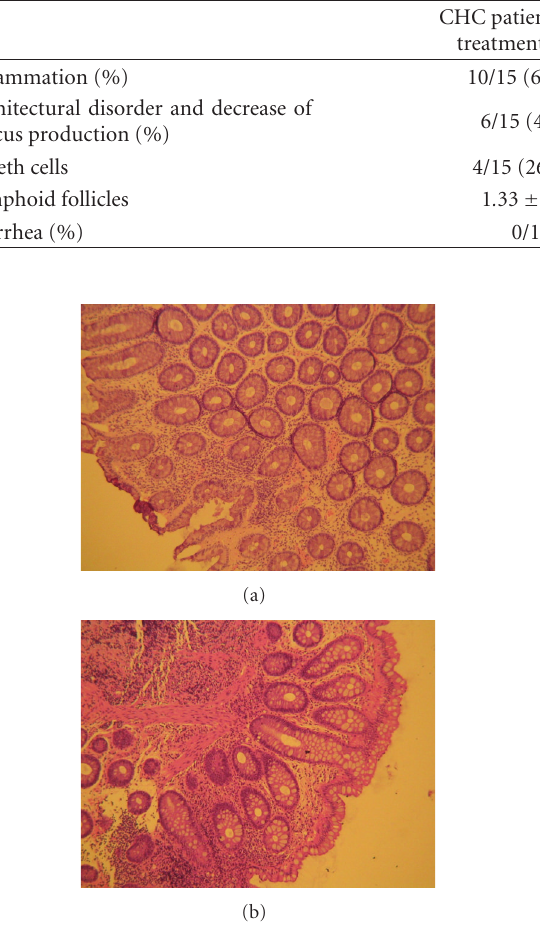
Figure 1: Histopathological evaluation of the large intestine at baseline (a) and at the onset of symptoms (b) revealed normal large intestine histology and mild chronic nonspecific colitis in the first patient with diarrhea,